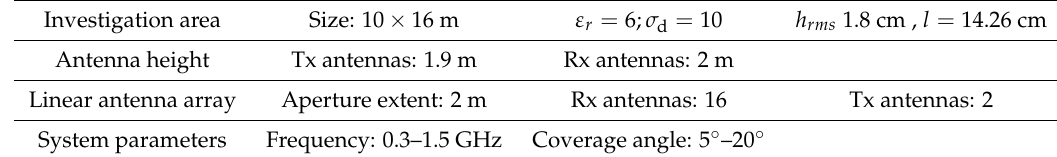
Table 1. Main characteristics of the radar system and the investigation